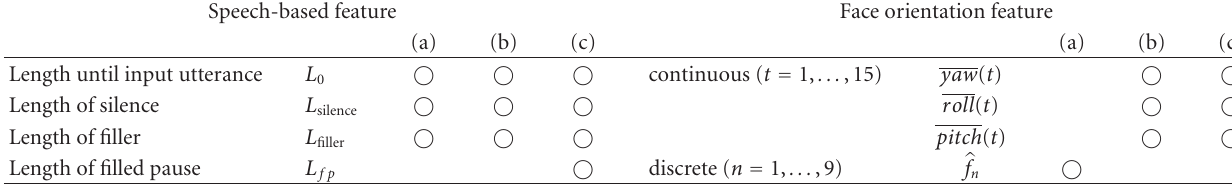
Figure 8: Calculation of face orientation feature. Table 6: Elements of feature vectors.